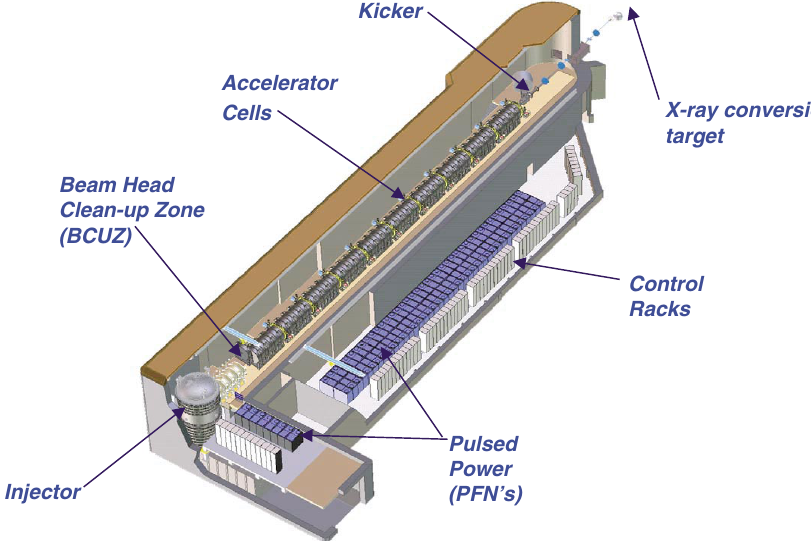
FIG. 1. (Color) Schematic of DARHT-2